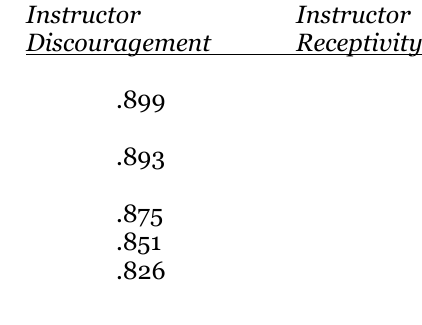
Item Loadings for Teacher Approachability Exploratory Factor